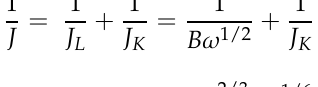
Figure S1: SEM image for Co 3 O 4 (7) / lsm -TiO 2 with cobalt oxide highlighted with yellow circles; Figure S2: XRD spectra of Co 3 O 4 (3) / lsm -TiO 2 , Co 3 O 4 (3) / hm -TiO 2 , and Co 3 O 4 (3) / bulk -TiO 2 ; Figure S3: Plot for the e ff ect of varying cobalt content on the average crystallite size of the Co 3 O 4 ( x ) / lsm -TiO 2 catalysts; Figure S4: SEM–EDX elements mapping of Co(3) / hm -TiO 2 ; Figure S5: SEM–EDX elements mapping of Co(3) / lsm -TiO 2 catalyst; Figure S6: Mott − Schottky plot of pure lsm -TiO 2 and Co 3 O 4 -modified lsm -TiO 2 electrodes measured at 500 Hz; Figure S7: LSV curves of Co 3 O 4 (3) / lsm -TiO 2 at a scan rate of 10 mV s − 1 and a rotation speed of 500, 1000, 1500, 2000, 2500, and 3000 rpm in O 2 -saturated 1.0 M KOH; Table S1: The atomic contents of Co, Ti, and O in lsm -TiO 2 and Co(3) / lsm